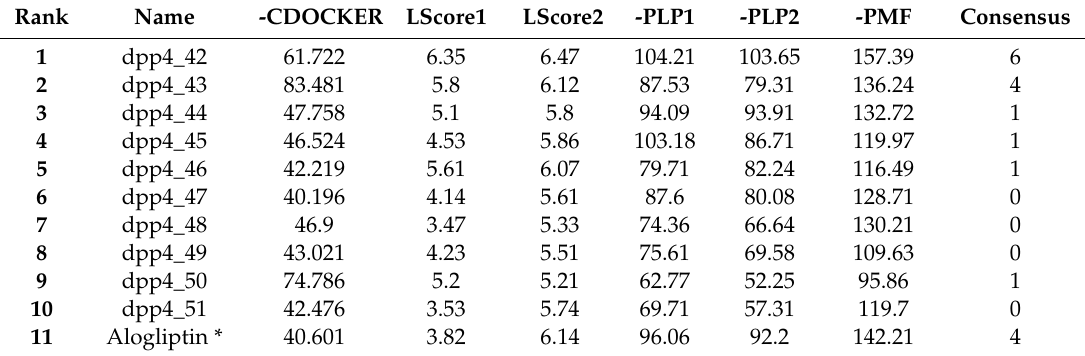
Table 3. Molecular docking results of the initial compound from